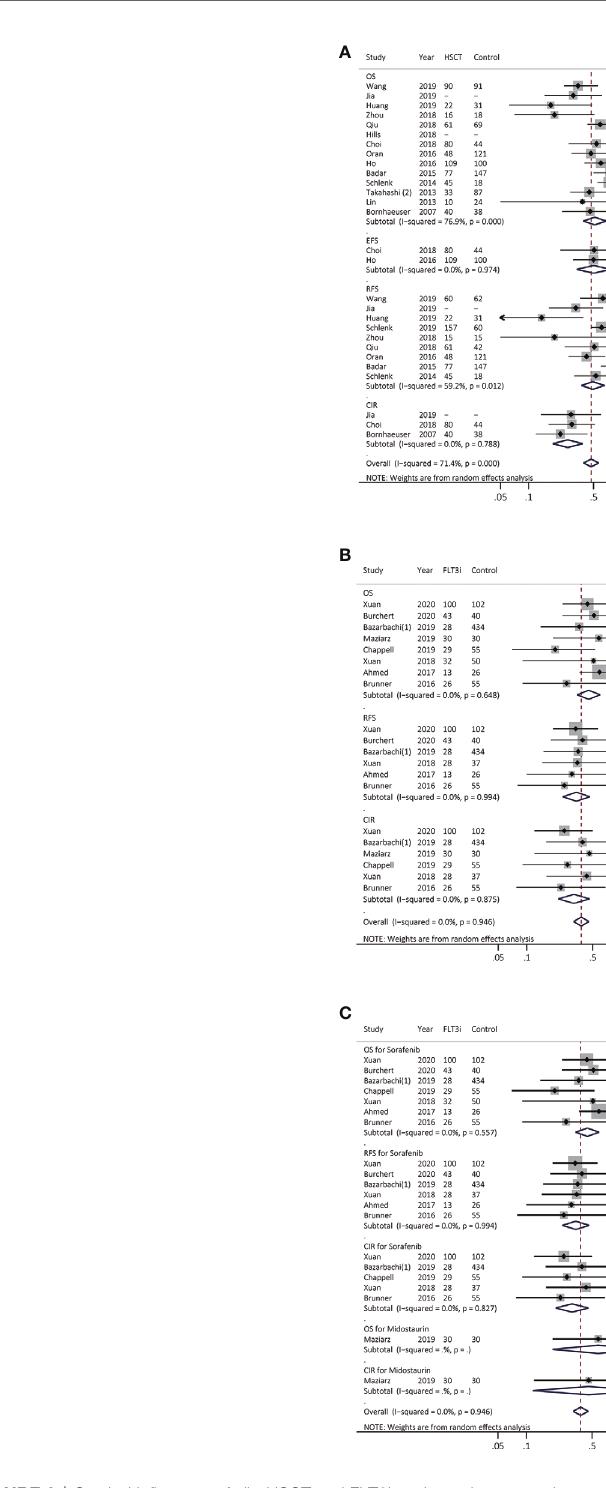
FIGURE 3 | Survival in fl uences of allo-HSCT and FLT3i as the maintenance therapy after allo-HSCT on FLT3(+) AML. (A) Pooled HR and 95% CI of allo-HSCT in FLT3 (+) AML for OS, EFS, RFS and CIR; (B) Pooled HR and 95% CI of all FLT3i as the maintenance therapy after allo-HSCT in FLT3 (+) AML for OS, RFS and CIR; (C) Pooled HR and 95% CI of each FLT3i as the maintenance therapy after allo-HSCT in FLT3 (+) AML for OS, RFS and CIR. FLT3, FMS-like tyrosine kinase 3; FLT3i, FLT3 inhibitor; Allo-HSCT, allogeneic hematopoietic stem cell transplant; AML, acute myeloid leukemia; OS, overall survival; EFS, event-free survival; RFS, relapse-free survival; CIR, cumulative incidence of relapse; HR, hazard ratio; 95% CI, 95% con fi dence